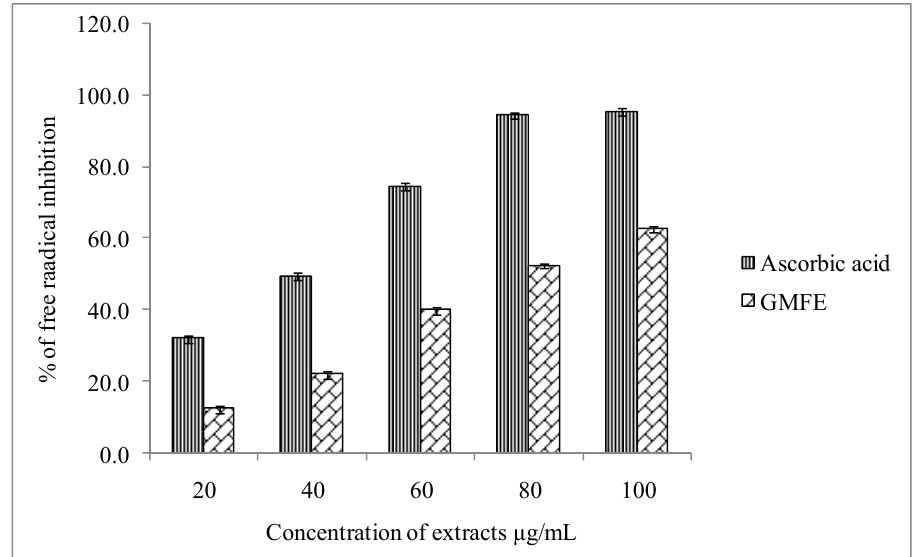
Figure 3. DPPH free radical scavenging assay of methanolic fruit extract of G. latifolia .